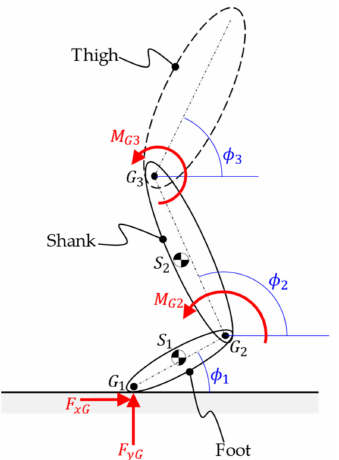
Figure A1. Planar view of limb with variables present in the mechanical